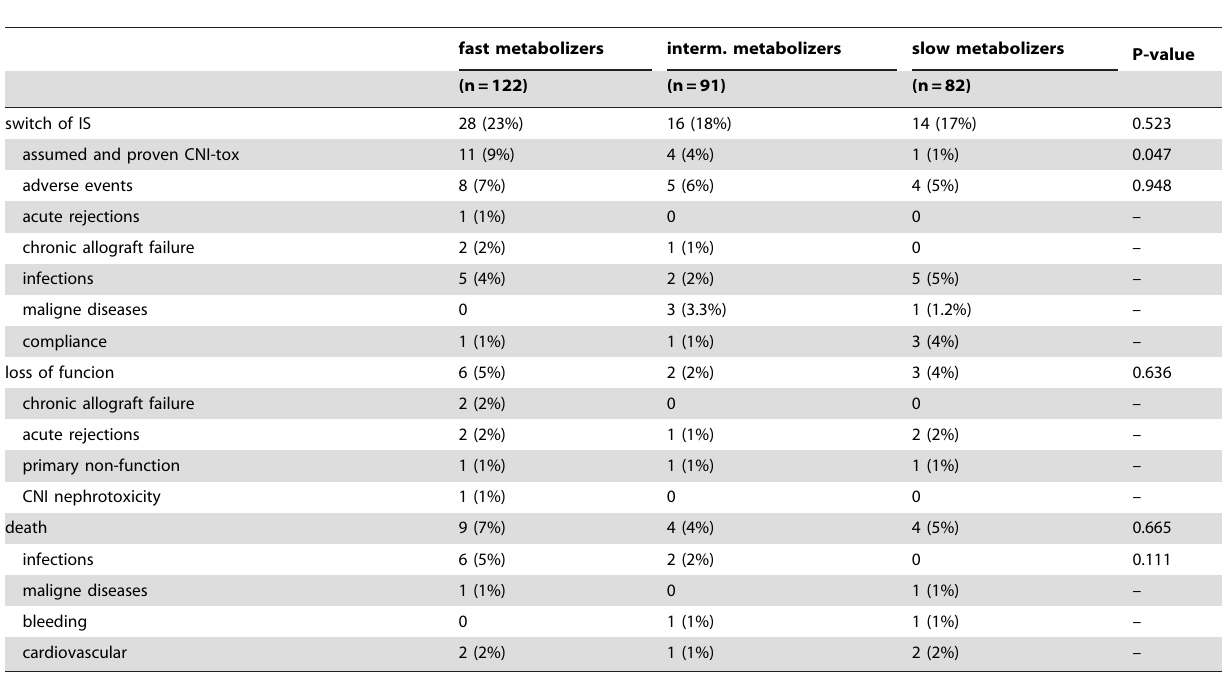
Table 5. Reasons for switching immunosuppression and adverse